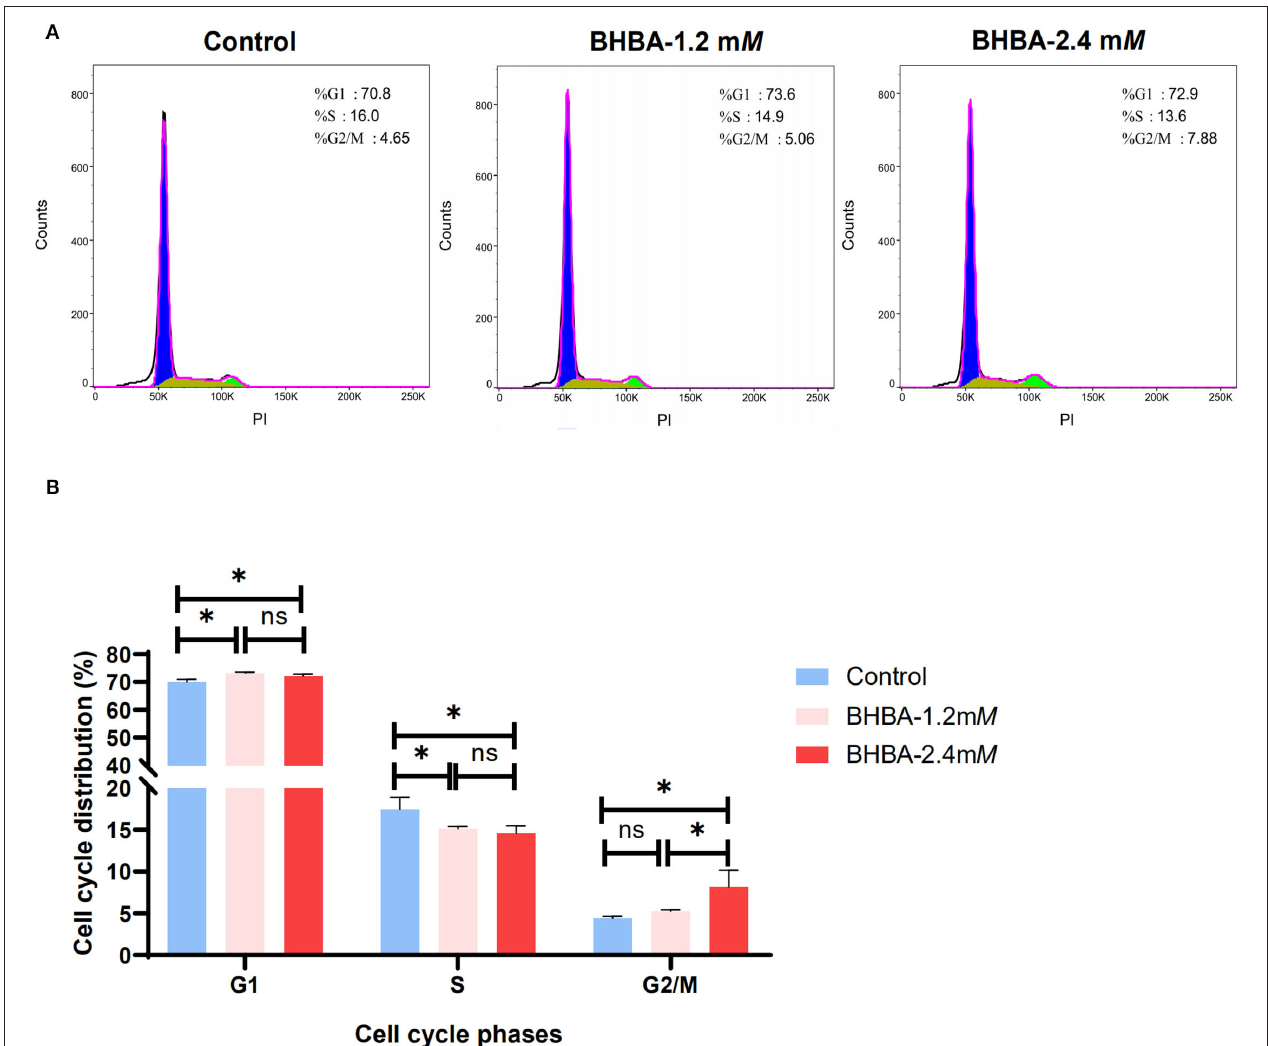
FIGURE 2 | Effect of different concentrations of BHBA stimulation on the cell cycle of GCs. (A) Flow cytometry analysis of the cell cycle phase distribution of GCs under different concentrations of BHBA stimulation. (B) Bar graph showing the mean ± SD of each group, compared to the control group, * P < 0.05, ns represents P >